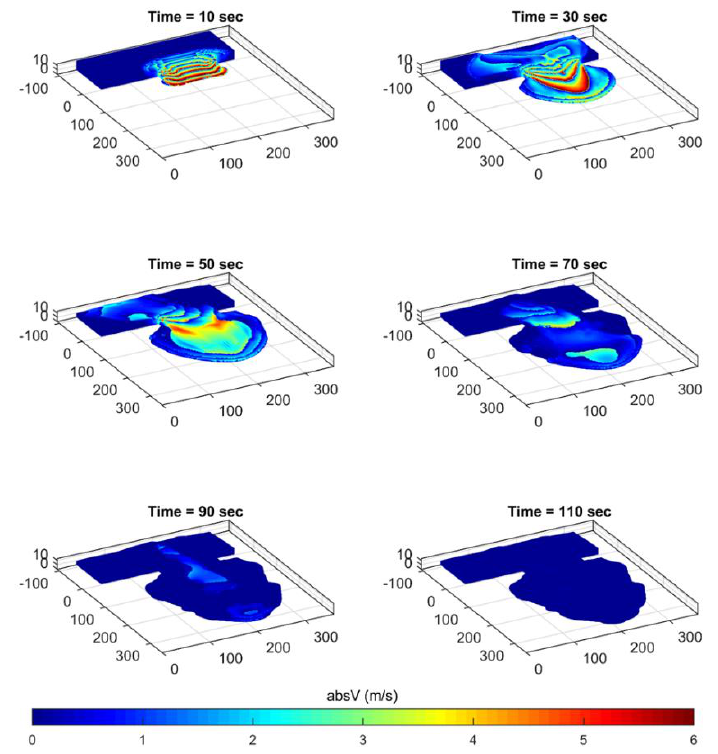
Figure 9. Snapshots of free-surface velocity profiles simulated by MBM.